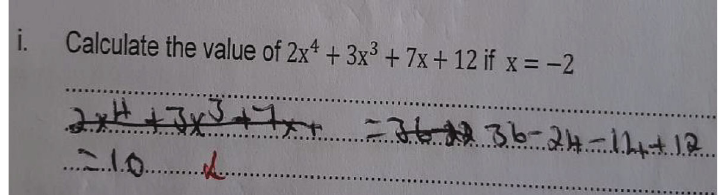
Figure 11: Learner L, School C.